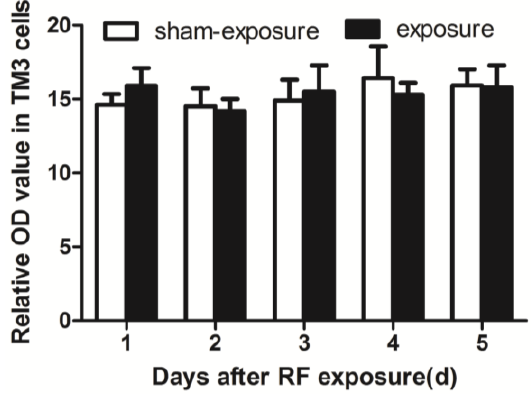
Figure 6. Effects of ROS levels in TM3 cells induced by RF-EMR. Values represent mean ± SEM for each of the exposure and sham-exposure groups at each time point.